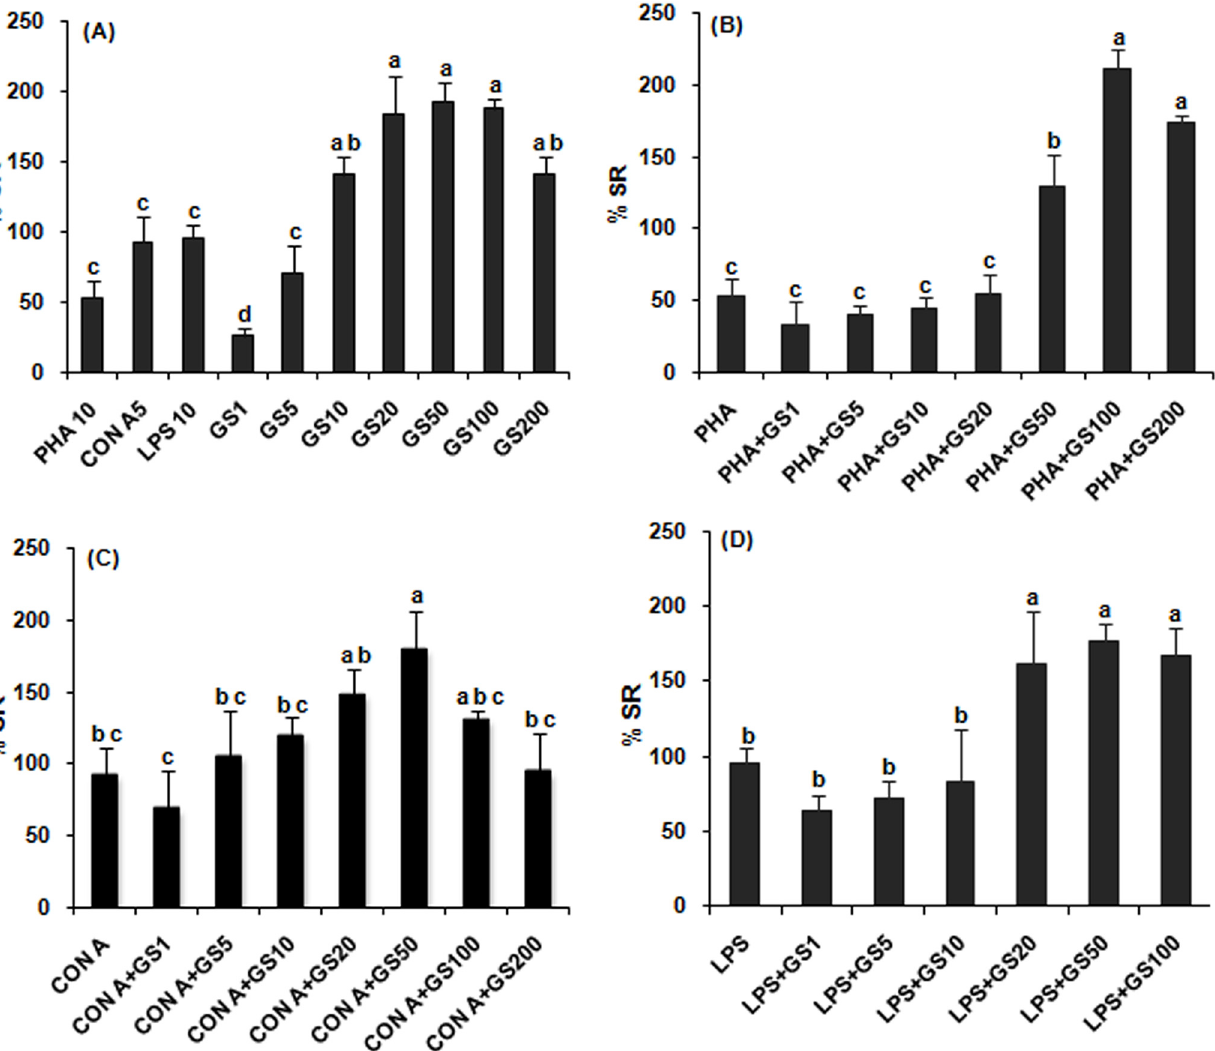
Fig 3. Proliferation of splenic lymphocytes in vitro treated with Gymnema sylvestre leaf extract alone (A) and in combination with PHA 10 μ g/ ml (B), ConA 5 μ g/ ml (C) and LPS 10 μ g/ml (D). GS1 – GS200 represent concentration of extract, 1 – 200 μ g/ml, respectively. Bars bearing same alphabet do not differ significantly. [Treatment effect ANOVA: (A) F = 10.58 (9, 20); p < 0.05, (B) F = 27.28(7, 16); p < 0.05, (C) F = 2.66 (7, 16); p < 0.05; (D) F = 5.26 (6, 14); p < 0.05].